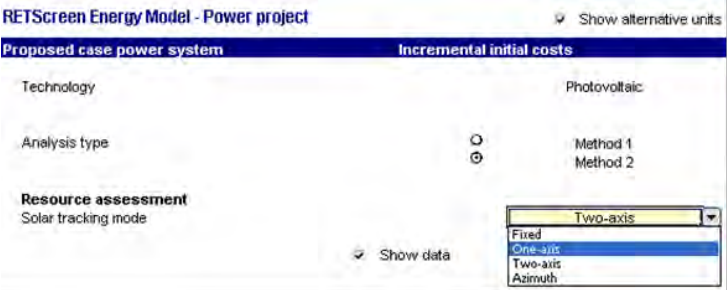
Figure 11. Data on the proposed renewable energy system Photovoltaic systems (”Renewable Energy Technologies Screen”, n.d.)